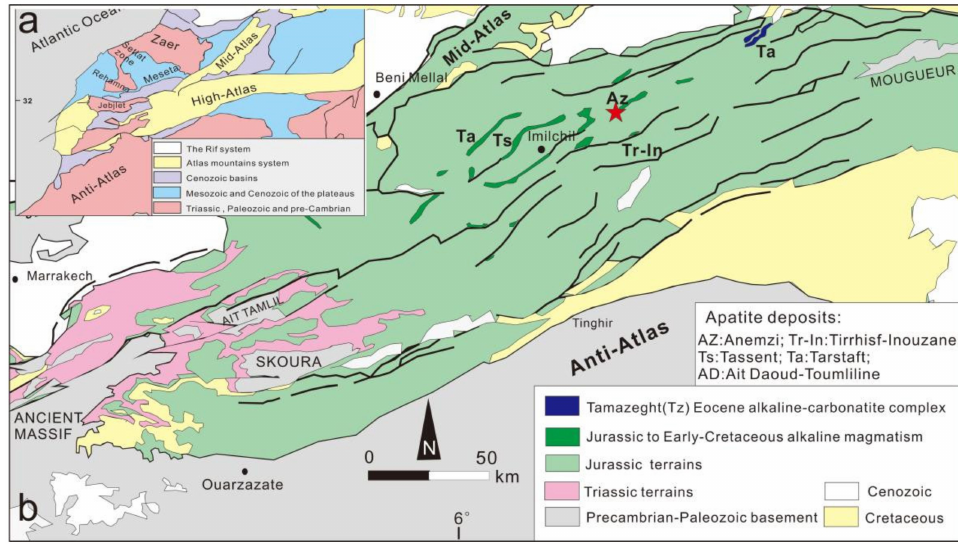
Figure 1. ( a ) Map of the Atlas Mountains in Morocco (the dashed box marks the study area in this paper). ( b ) Geological map of the High Atlas Mountains, with the samples marked with a red star. Modified from [6] and the references within